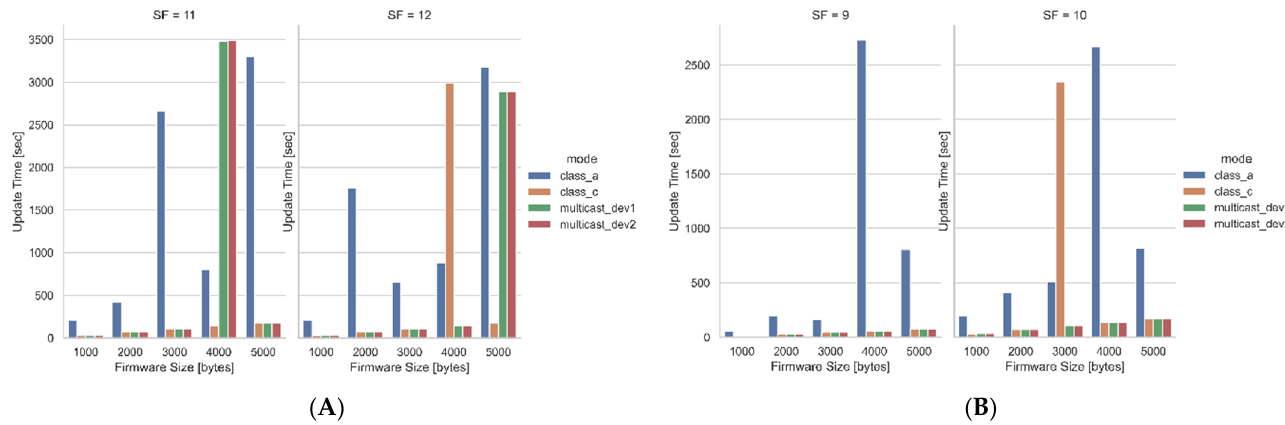
Figure 20. ( A ) Update Time for SF11 and SF12; ( B ) Update Time for SF9 and SF10.